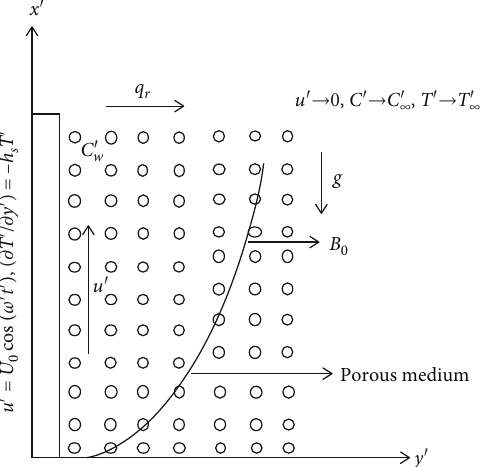
Figure 1: Schematic drawing of the